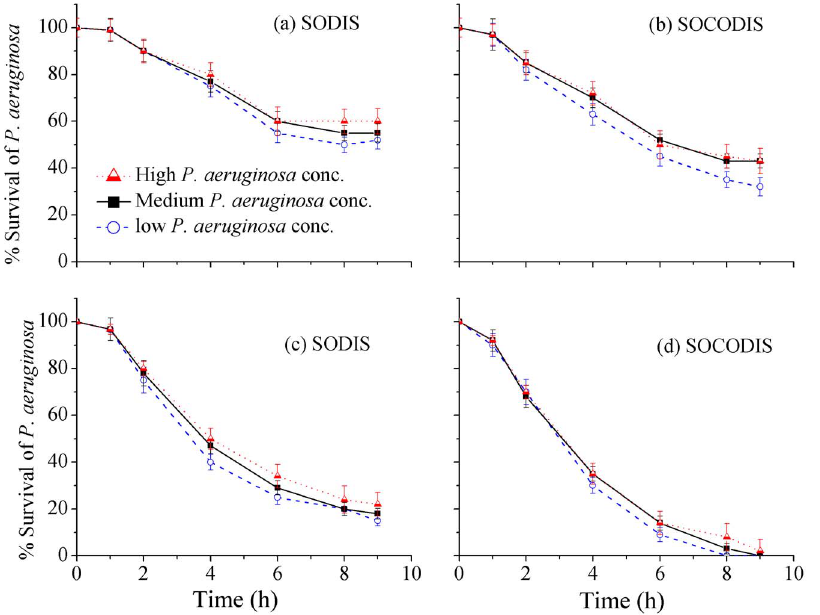
Figure 6. Effects of different initial P.aeruginosa concentratinos on disinfection efficiency in both SODIS and SOCODIS system under weak (a & b) and mild (c & d) weather conditions.